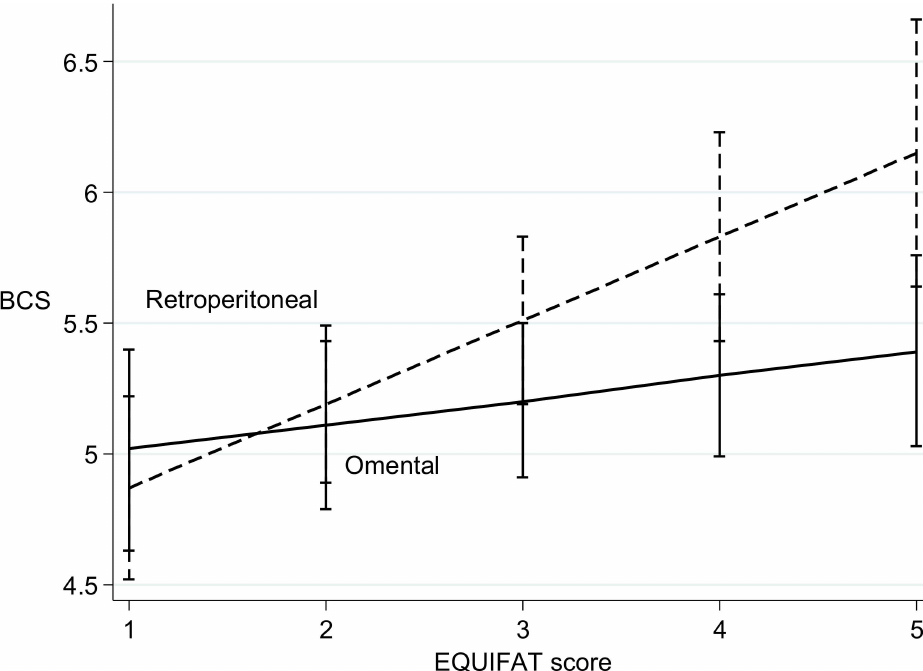
Fig 4. Marginal mean plots illustrating predicted changes in BCS with retroperitoneal and omental EQUIFAT scores. Marginalmean plots were created from the final multivariable model 1 to demonstrate predicted changesin BCS with increasingretroperitoneal and omentalEQUIFAT scores. Error bars signify 95% confidenceintervals.